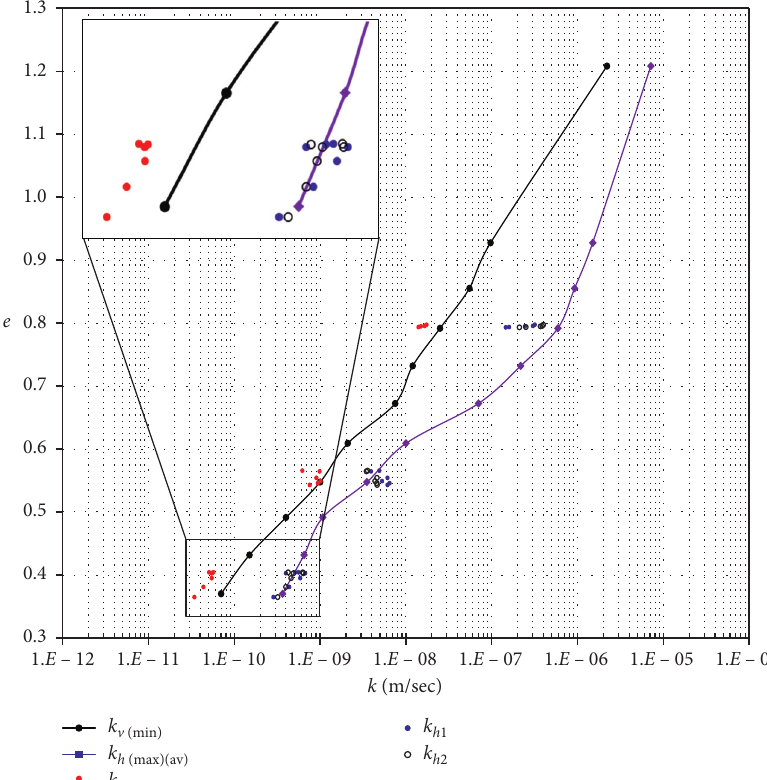
Figure 10: The plot of the k v , k h 1 , and k h 2 values measured during simple shear deformation on the k h (max) and